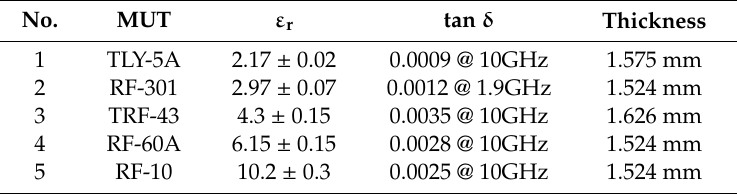
Figure 8. Experiment setups: ( a ) unloaded and ( b ) loaded. Table 2. Relative permittivity, loss tangent, and thickness of the five MUTs.